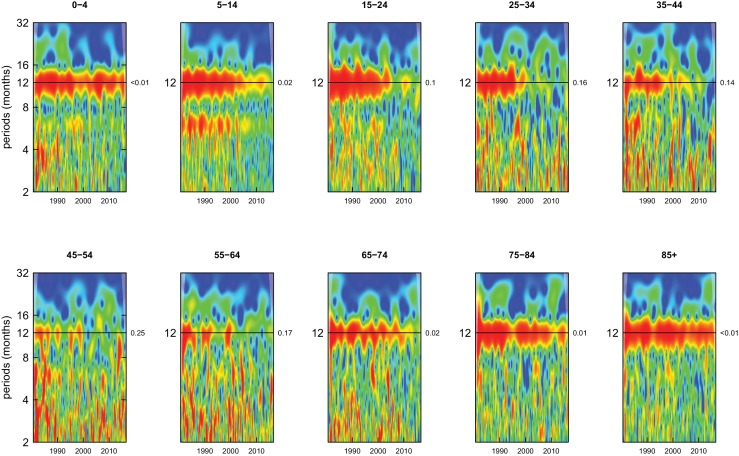
Wavelet power spectra for national time series of unintentional injury death rates for 1980–2016, by age group for females.Wavelet power values increase from blue to red. The shaded regions at the left and right edge of each box indicate the cone of influence, where spectral analysis is less robust. P-values for the presence of 12 month seasonality are to the right of each figure at the 12 month line.